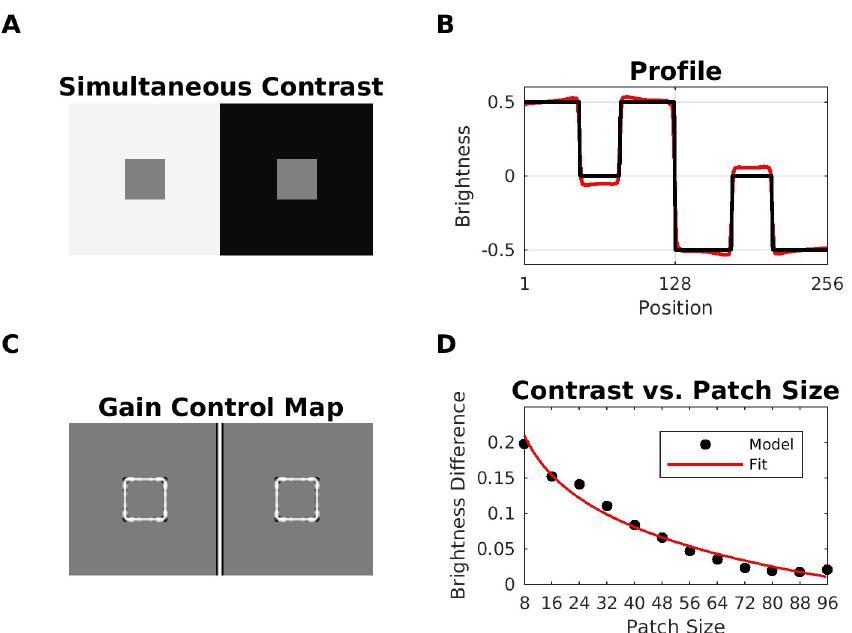
Fig 9. Model prediction for simultaneous brightness contrast (SBC). (A) Simultaneous brightness contrast display (model input). (B) The corresponding Gain Control Map. (C) Profile plot of the estimated brightness map (red line) and the input (black line). (D) Mean absolute brightness difference between the left and the right patch as predicted by our model (filled circles). The continuous (red) lines show the fit of y = a + b log( x ) to the model data. The fit was carried out by linear regression with fitting parameters: intercept a = − 0.3851, slope b = − 0.0823, R 2 = 0.9831, and RMSE =